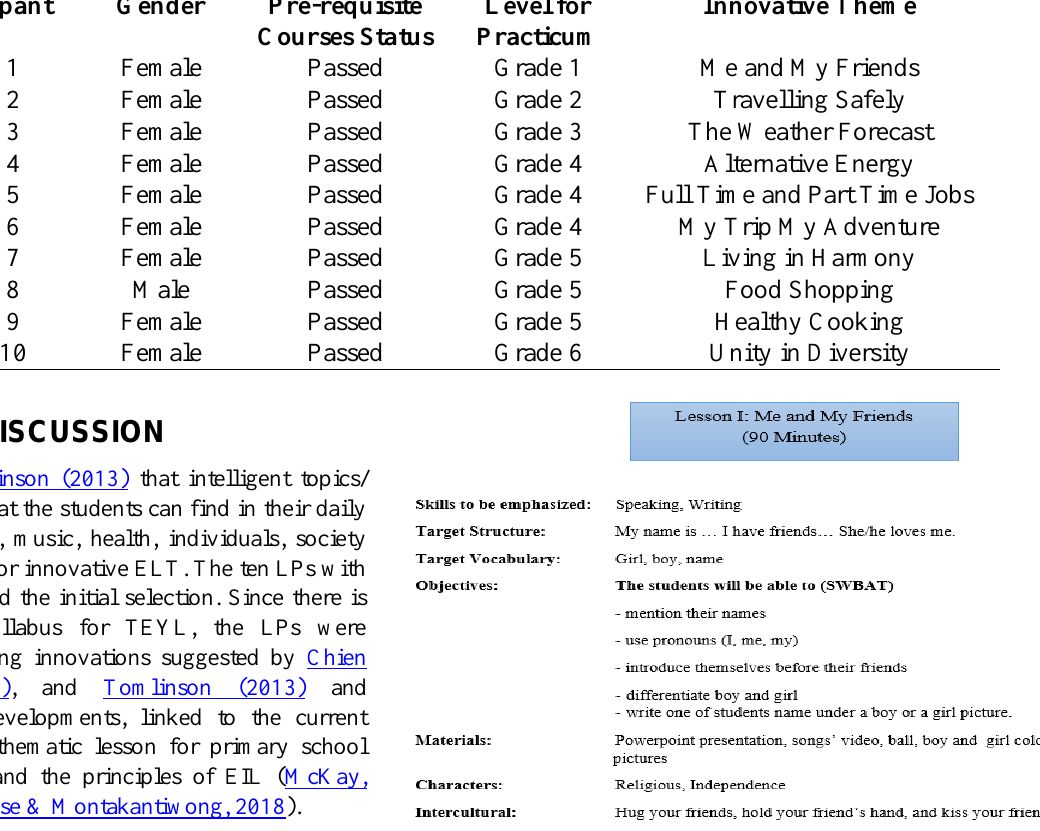
TABLE 1 | Participants Demographic Information